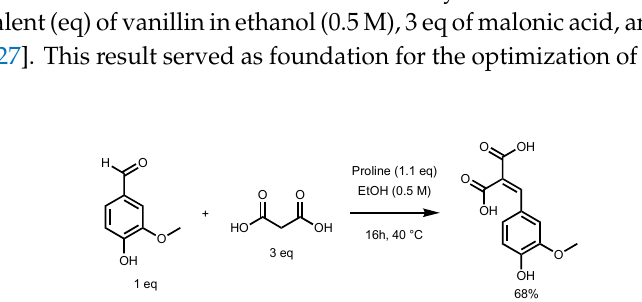
Figure 3. Non-optimized reaction conditions to access ferulic diacid.